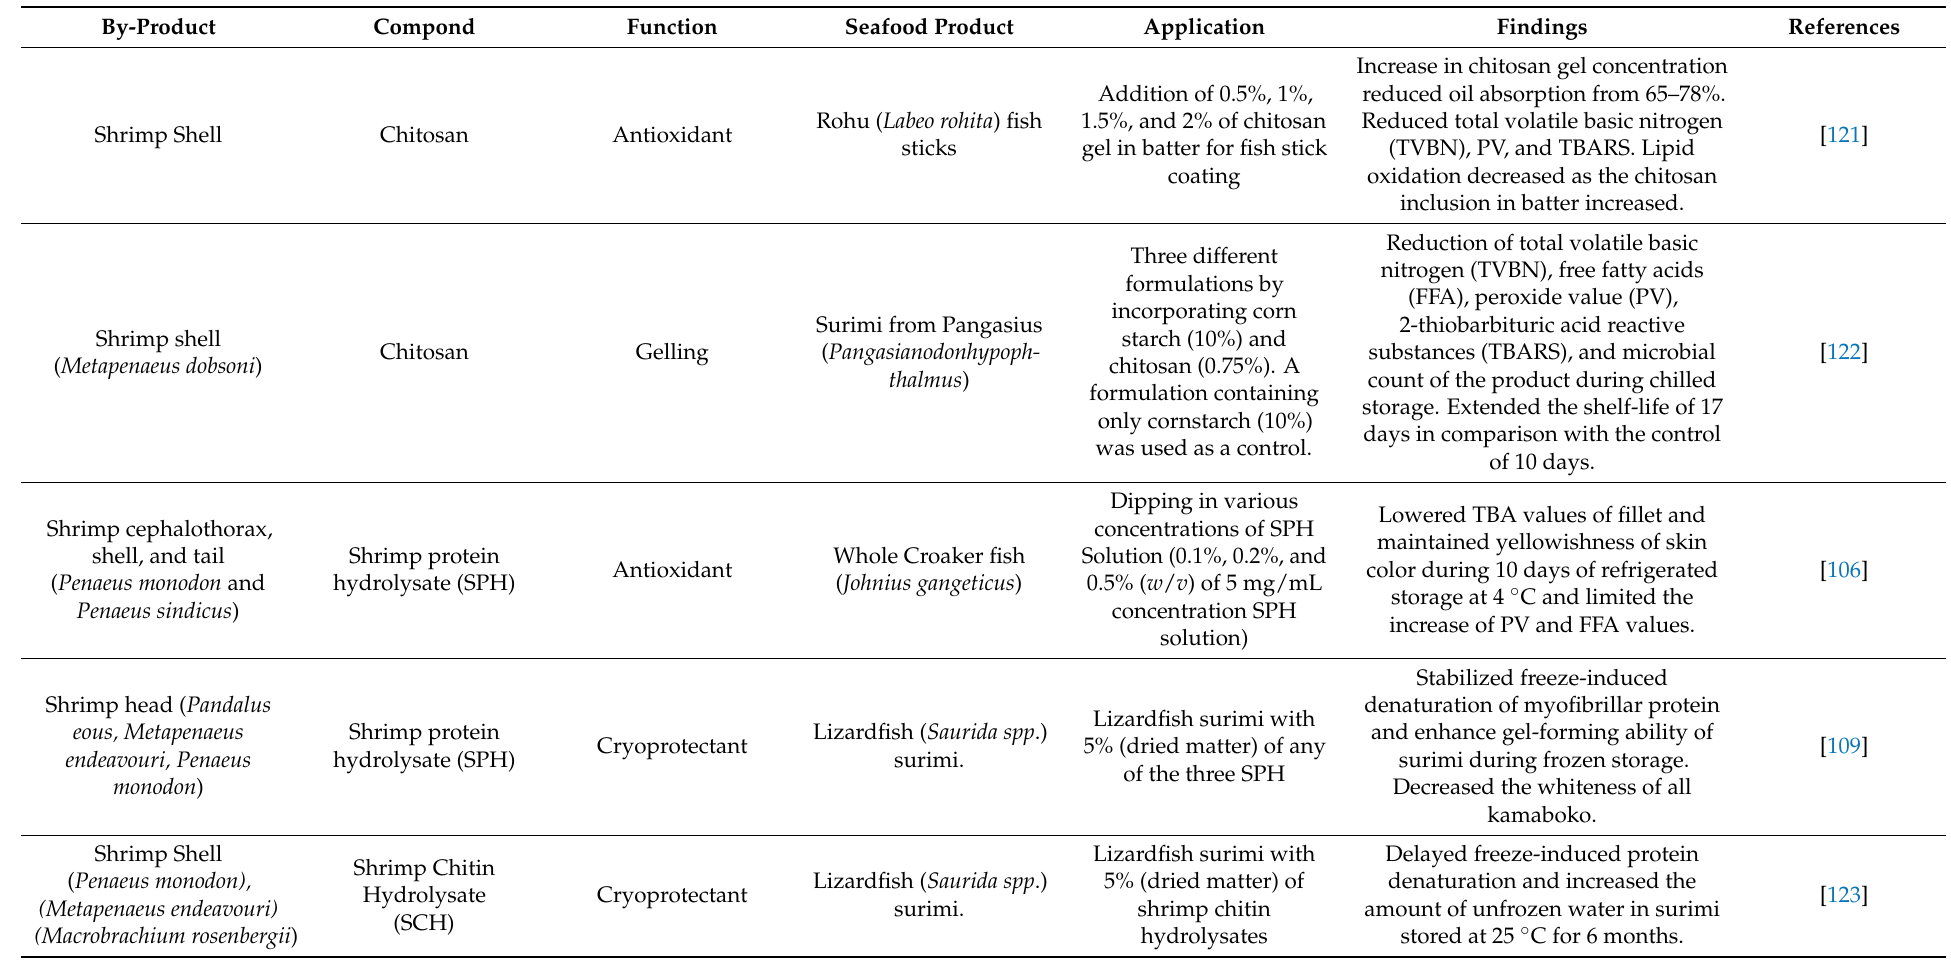
Table 5. Application of bioactive compounds or products obtained from crustacean by-products in seafood